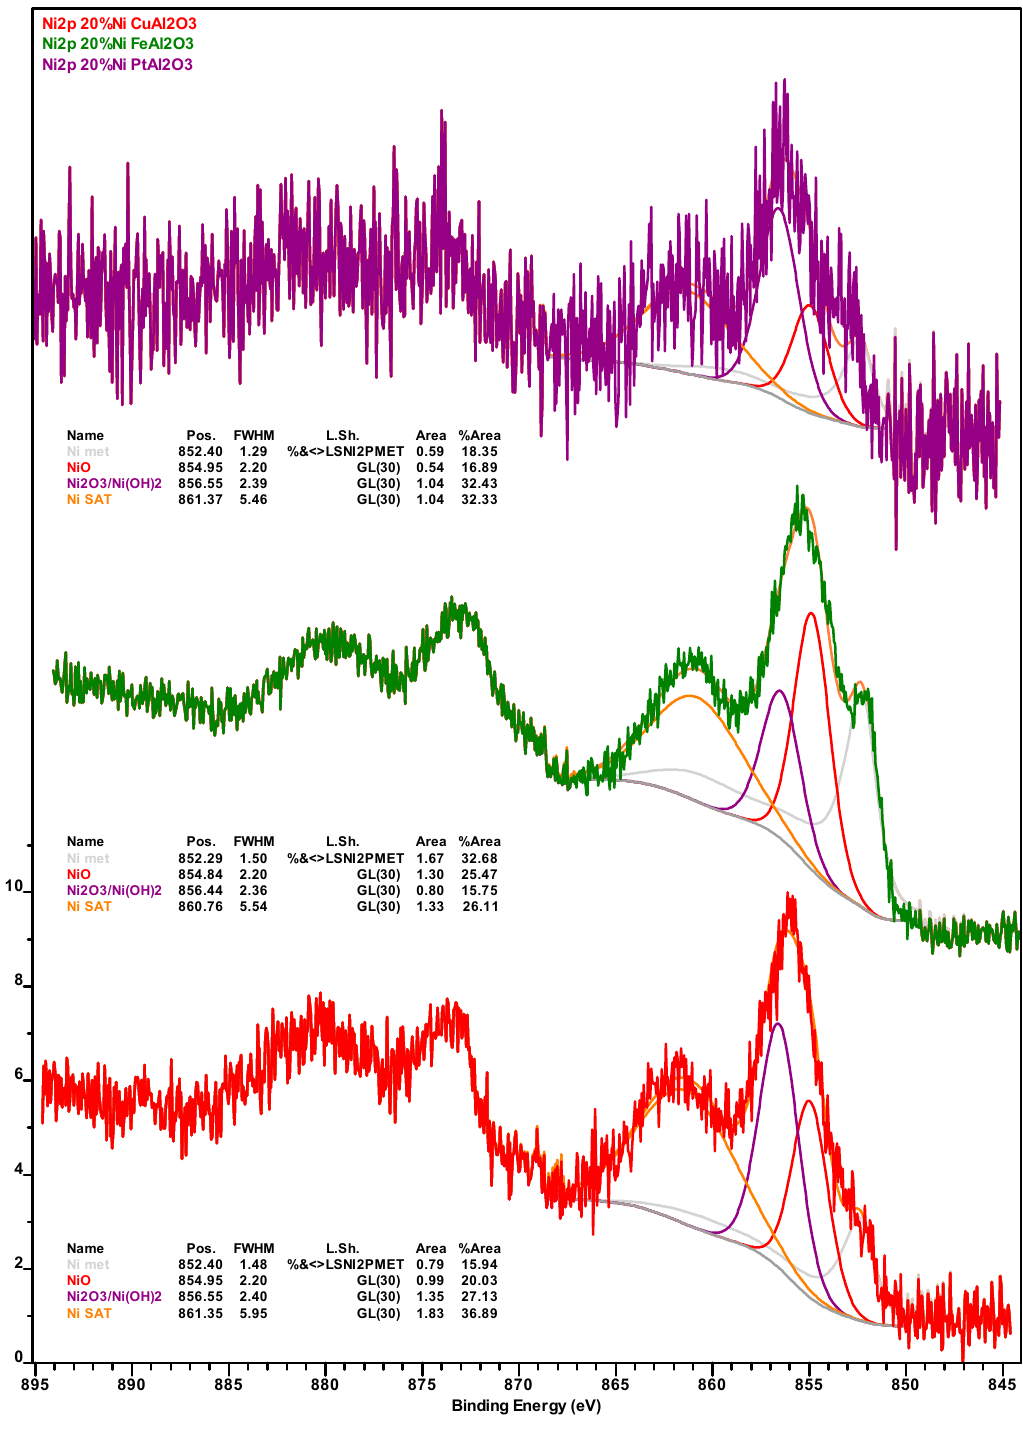
Figure A1. Nickel 2p X-ray photoelectron spectra of the spent Ni-Cu (red spectrum), Ni-Fe (green spectrum) and Ni-Pt (purple spectrum) catalysts recovered from deoxygenation experiments.